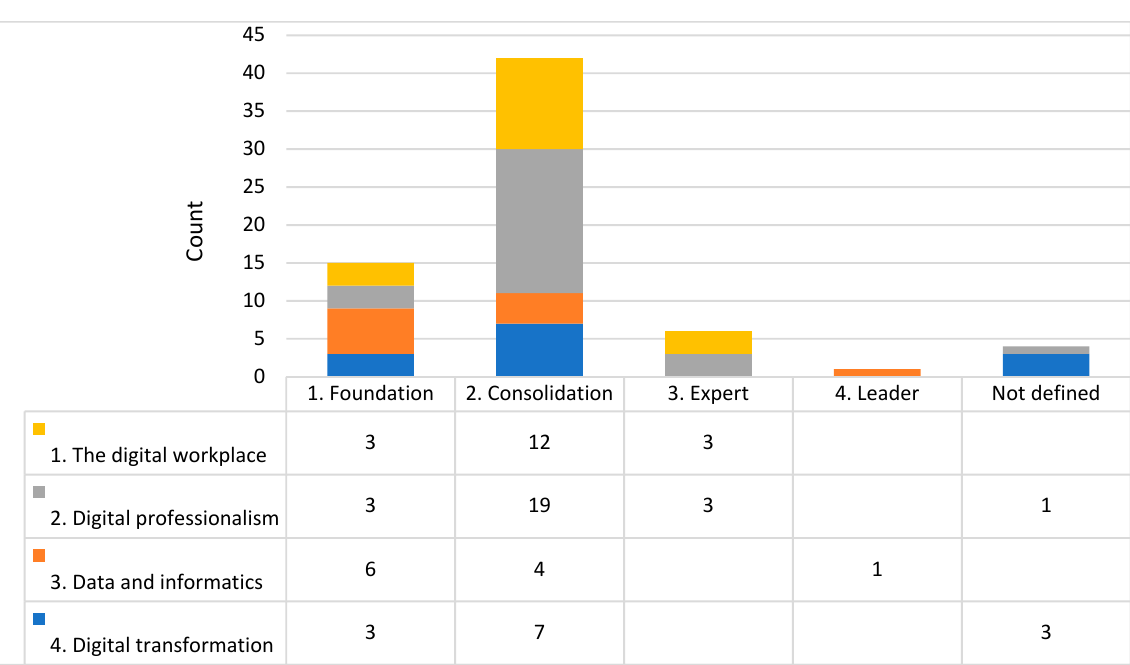
Figure 3. Histogram of self-rated digital capability for the allied health workforce. NB each number represents the number of times (counts) the domain and level were mentioned in the focus groups.